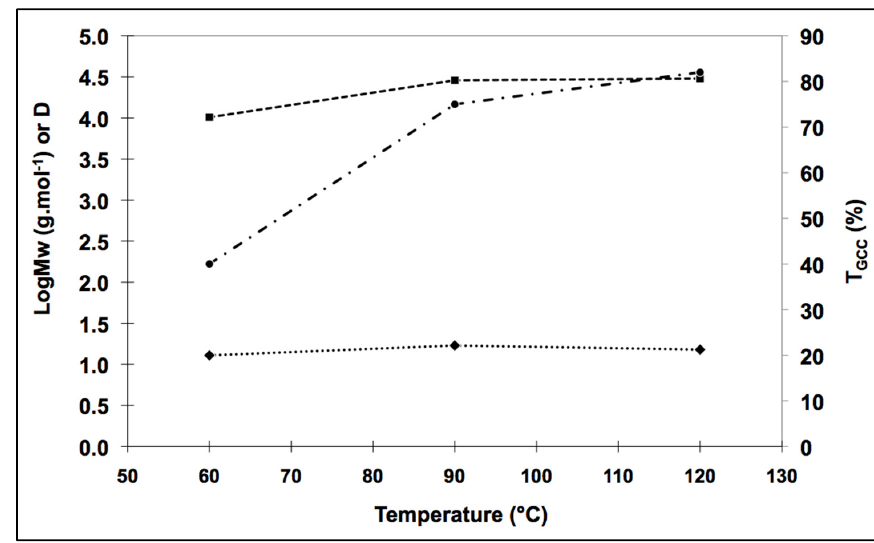
Figure 2. One-pot strategy; impact of the temperature on molar mass, dispersity index, and conversion rate for HMDA addition on GCA; ( ■ ) Log Mw, ( ) D, ( ● ) T GCC . Benyahya et al. [26] obtained a polymer with a number-average molar mass of 20,000 g·mol − 1 , but with a less favorable D of 2.5, in a reaction using a linear diamine as dodecadecyldiamine. We have shown that the Aza-Michael reaction is the fastest step in our sequential polymerization approach. The concentration of the amine would, therefore, be expected to have only a small effect on reaction kinetics. We thus consider the reaction to be a pseudo-order 1 reaction, rather than a